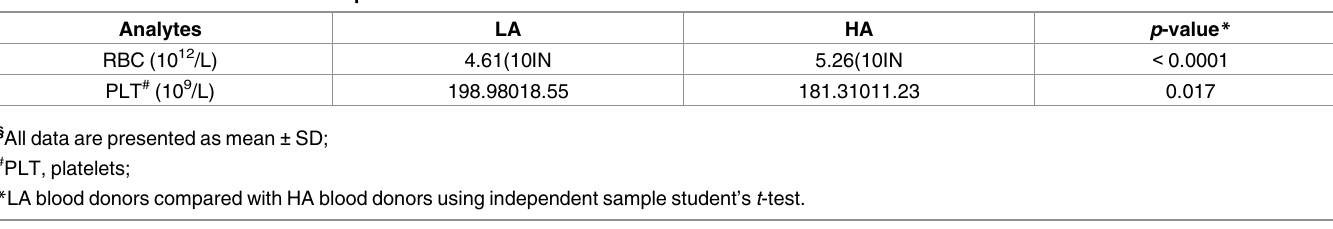
Table 2. Counts of red blood cells and platelets. §